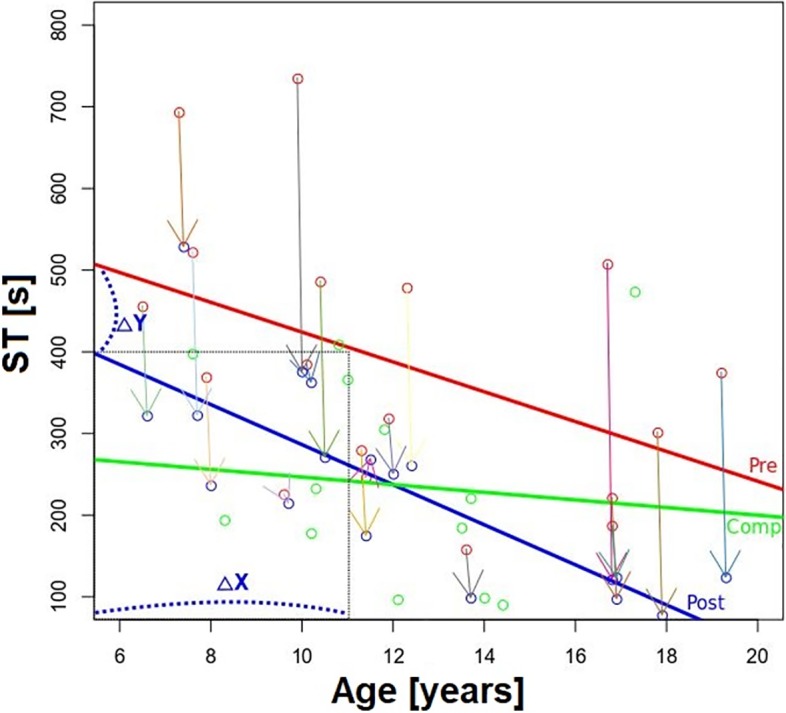
The effect of training vs. spontaneous adaptation and natural development by age.Red and blue circles represent performance before (Pre) and after (Post) training, while color-coded arrows indicate individual ST gains after training. The red line is the linear fit between age and ST before training and represents the spontaneous adaptation and natural development in children with HH. The blue line is the linear fit between age and STs after training. The amount of ST improvement obtained by training (delta Y, blue stippled line) is about 130 s (average over all patients) and could theoretically only be achieved after approximately 6 years of spontaneous adaptation (delta X). The green line represents the STs of the healthy children, showing only a small decrease with natural development. Arrows represent individual improvements of the patients before and after training.